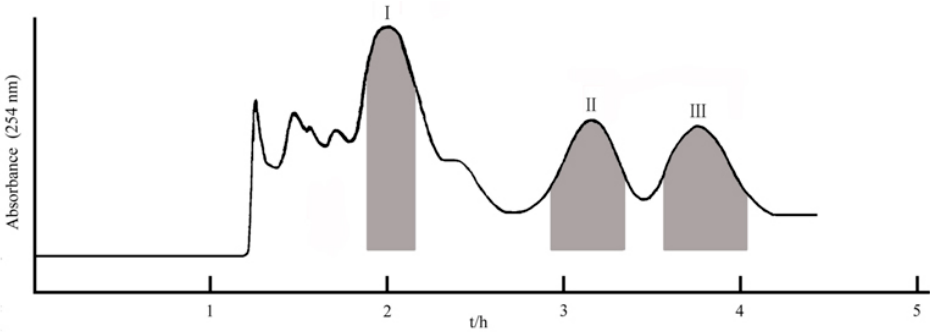
Figure 3. HSCCC chromatogram of the crude sample of D. glaucescens . Solvent system: ethyl acetate– n -butanol–ethanol–water (3:0.2:0.8:3, v / v ); revolution speed: 850 r/min; flow rate: 2.0 mL/min; sample size: 260 mg; UV detection wavelength: 254 nm.